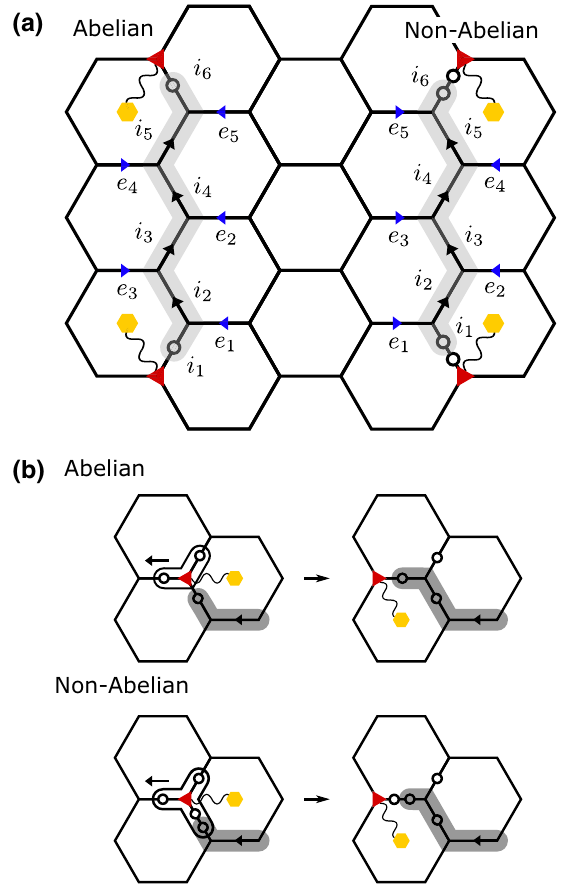
FIG. 6. Preparing and moving anyons with unitary string oper- ators. (a) Open-string operators for Abelian (left) and non- Abelian (right) anyons. The operators act on the set of labeled qudits { i } along the path and { e } of the legs. Only the states of the qudits { i } along the path are changed by the operator. Each quasi- particle has an associated vertex (red) and plaquette (yellow). Before the string operators are applied, the ancillary qudits in the non-Abelian case are initialized to align with the other qudits on the same edge. (b) The endpoint quasiparticles can be moved by extending the string operator sequentially with unitary gates. The dark gray marks the existing string. The enclosed qudits on the left are acted on by the endpoint-moving unitary gates, which correspond to an exact (modified) form of the unitary string oper- ators for the Abelian (non-Abelian) case. The plaquette-vertex labels are used to locate the quasiparticle. When extending the string operator, they trace the motion of the quasiparticle. Note that the ancillary qudit in the non-Abelian case can be moved without physically displacing the qudits. For more details, see Appendices B and